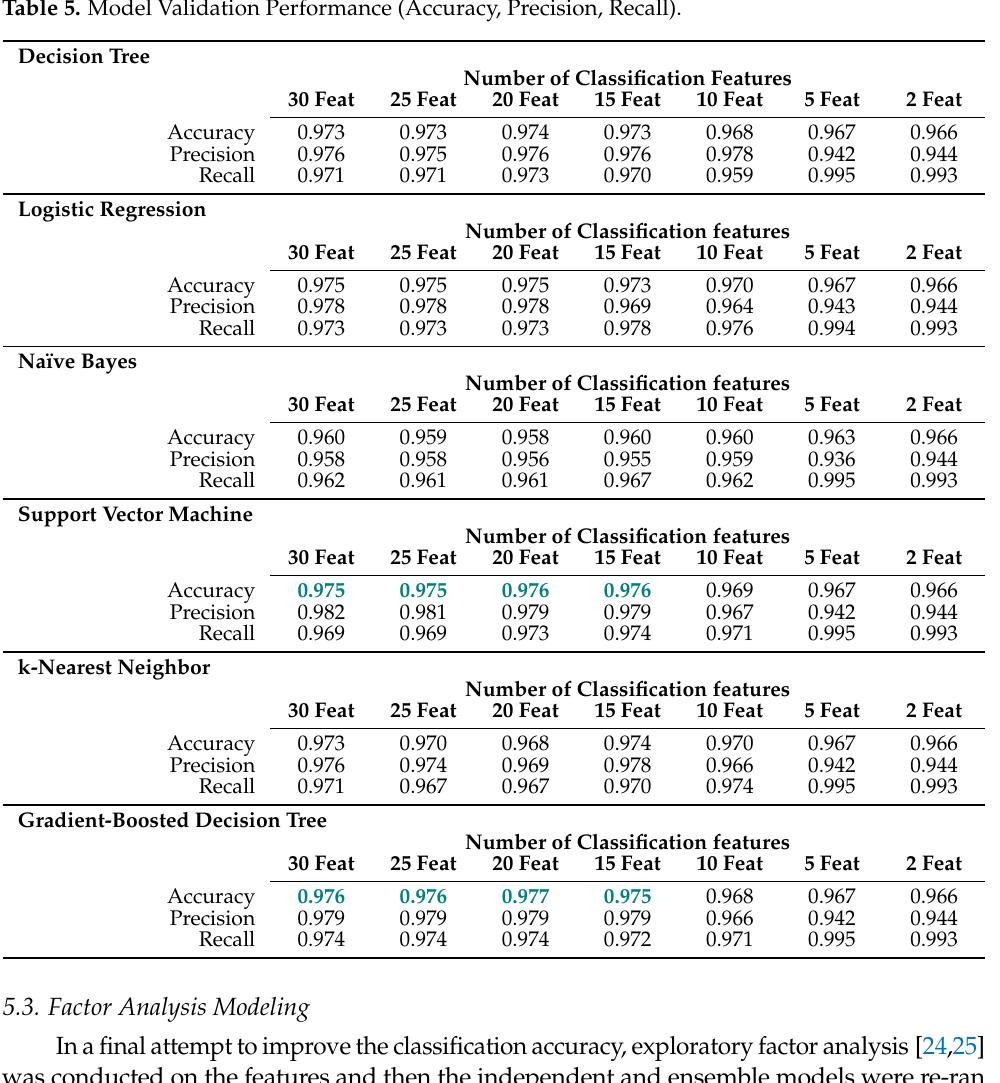
Table 5. Model Validation Performance (Accuracy, Precision,